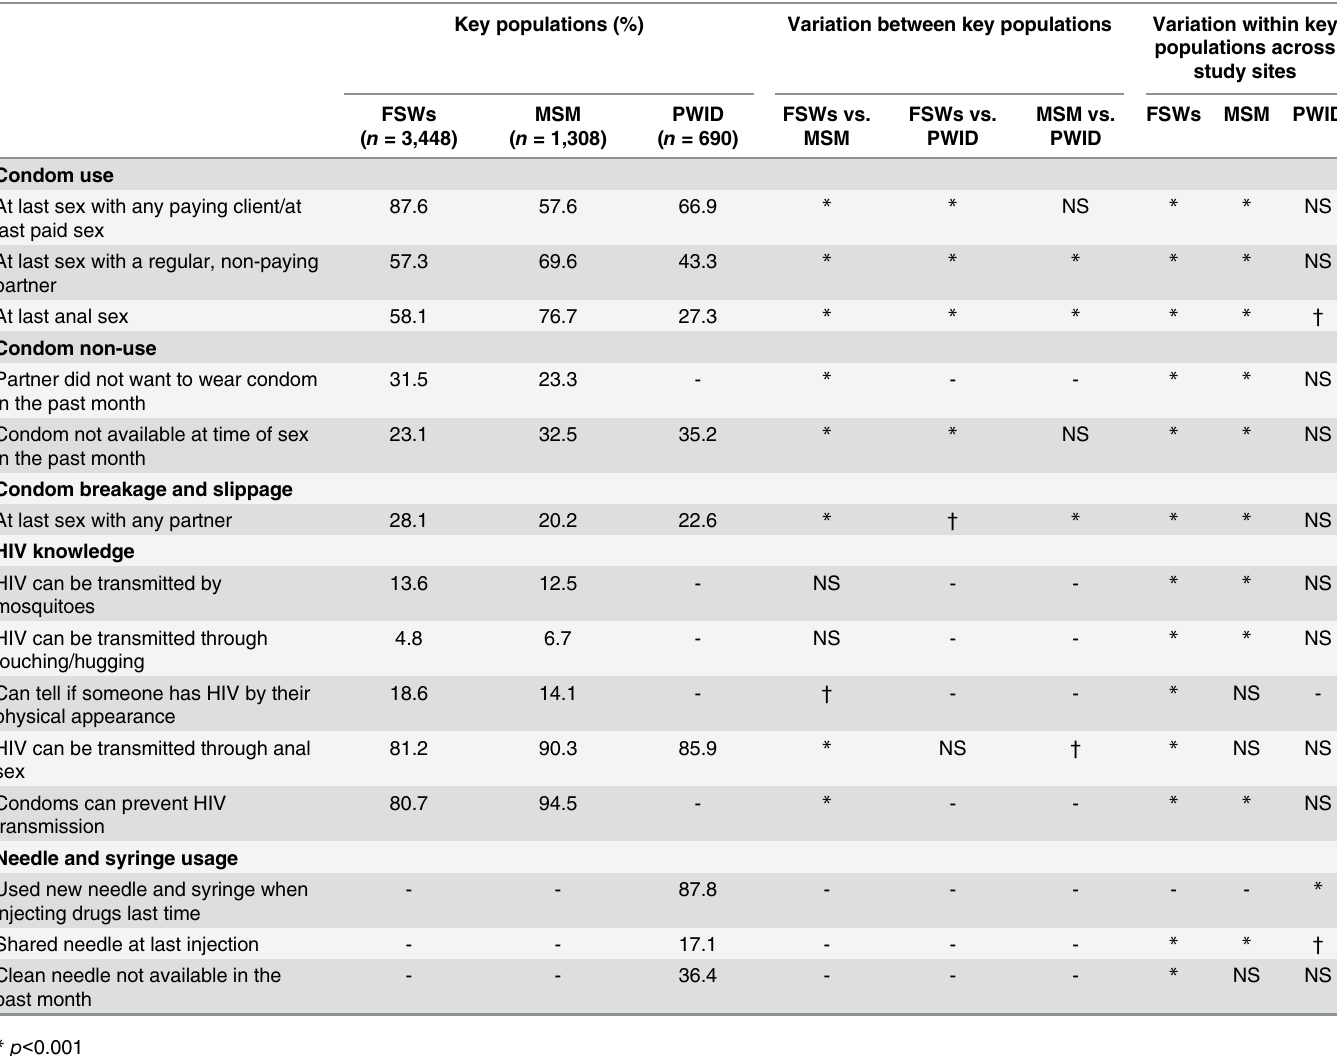
Table 3. Self-reported HIV risk or preventive behaviours among polling booth survey